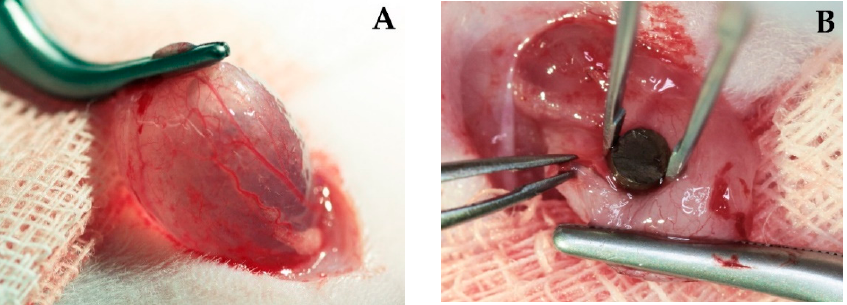
Figure 10. ( A ) rat urinary bladder, ( B ) implantation of a sample: Elastollan + barium sulphate + amorphous carbon layer, in combination with a-C:H/Cu-mulitilayer coating. The selected concentration of barium sulphate (25%) in the base material Elastollan showed sufficient X-ray contrast for the intravesical implants (Figure 11).